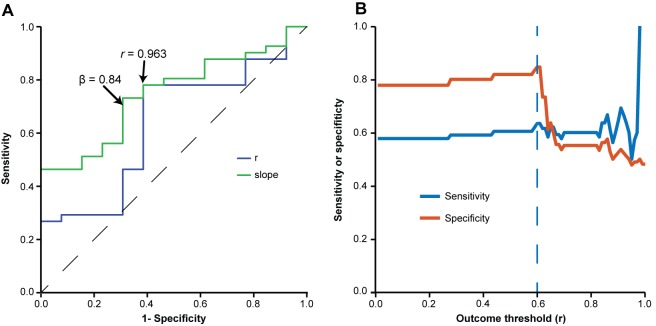
Evaluation of minimum criteria for valid videos. (A) Receiver operating characteristic (ROC) curve used for estimating accuracy, sensitivity and specificity of different r-values (blue line) and slopes (green line) at calibration to predict a correlation with r > 0.6 for the whole video set. Optimal sensitivity and specificity values to detect valid videos were 0.73 and 0.64 for r > 0.963 and 0.70 and 0.71 for β > 0.84. (B) Line graph depicting sensitivity (y axis, blue line) and specificity (y axis, orange line) of the chosen validation criteria (r > 0.963 and β > 0.84) to predict different minimum values of r in the whole video set (x axis).